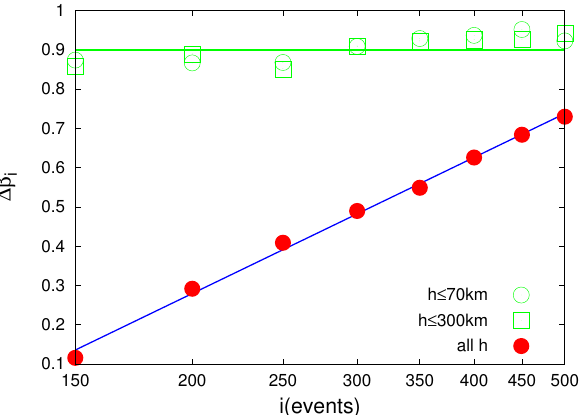
Figure 13. Comparison of the variation ∆ β i of the increase of β i upon the M 7.8 EQ occurrence on 22 December 2010 versus the window length i , for i = 150–500 events, when considering all M ≥ 3.5 EQs, i.e., irrespective of their depth h (red solid dots)—as shown in Figure 12h—with that obtained when restricting ourselves either to shallow EQs with depths h ≤ 70 km (green circles) or to shallow and intermediate depth EQs with h ≤ 300 km (green squares). The green horizontal line was drawn just as a guide to the eye. Taken from Ref.